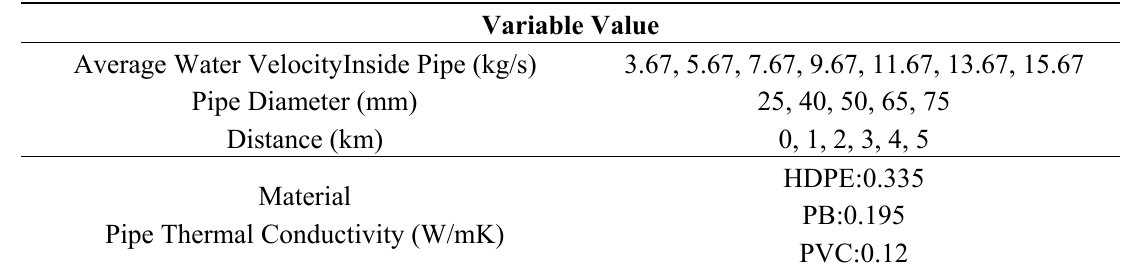
Table 2. Simulation conditions